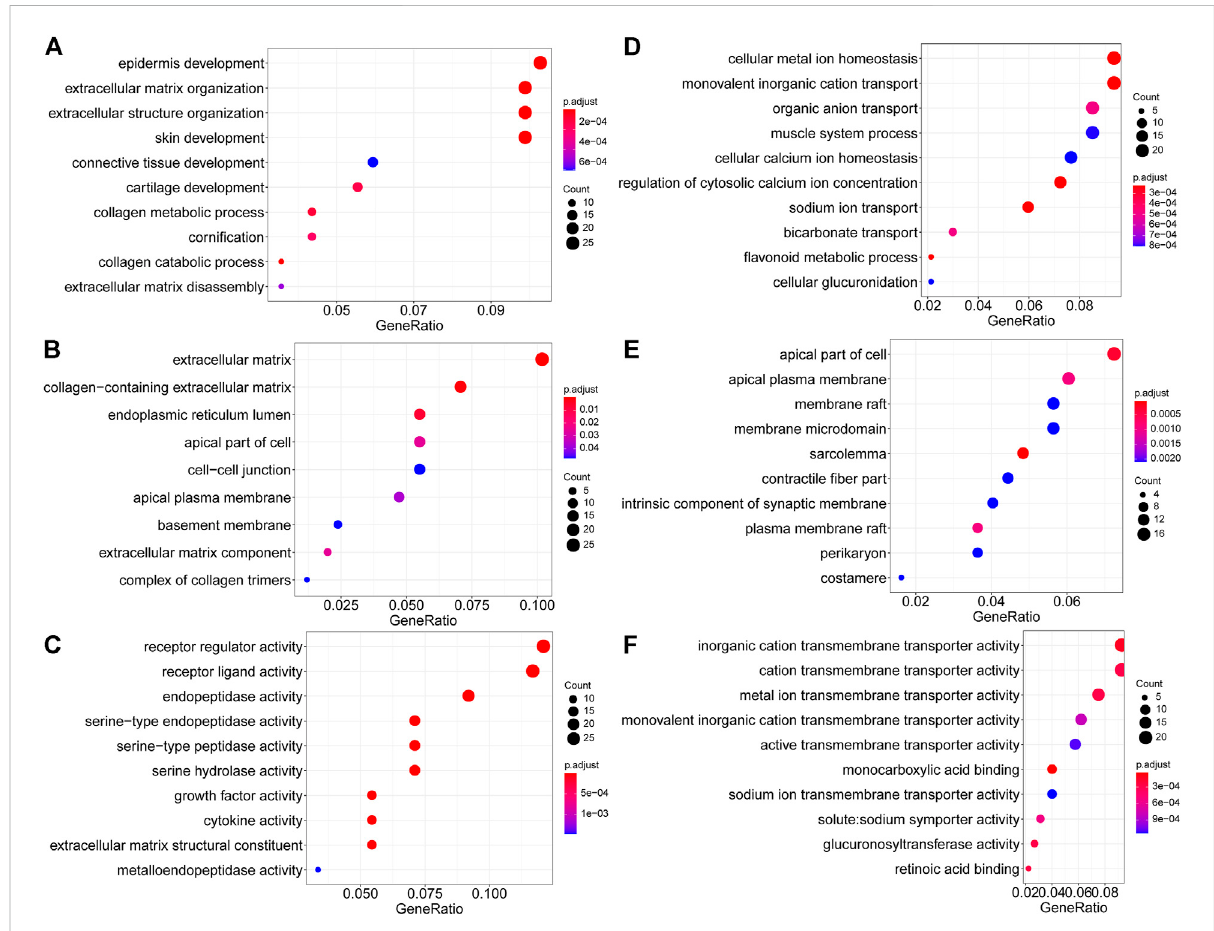
FIGURE 4 GO enrichment analysis of DEGs. (A – C) Upregulated DEGs. (A) . Biological process. (B) Cellular component. (C) Molecular function. (D – F) . Downregulated DEGs. (D) . Biological process. (E) Cellular component. (F) Molecular